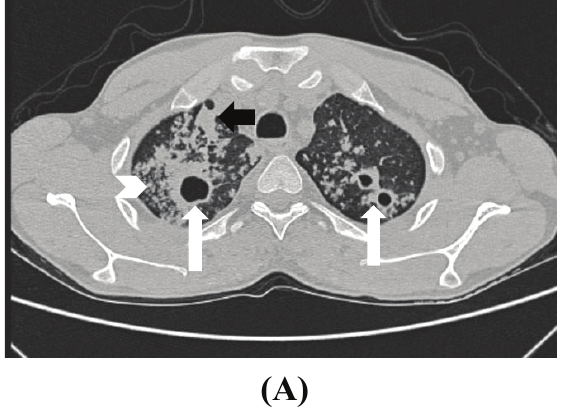
3 cases, respectively (Table 7). There was no case of pneumothorax in